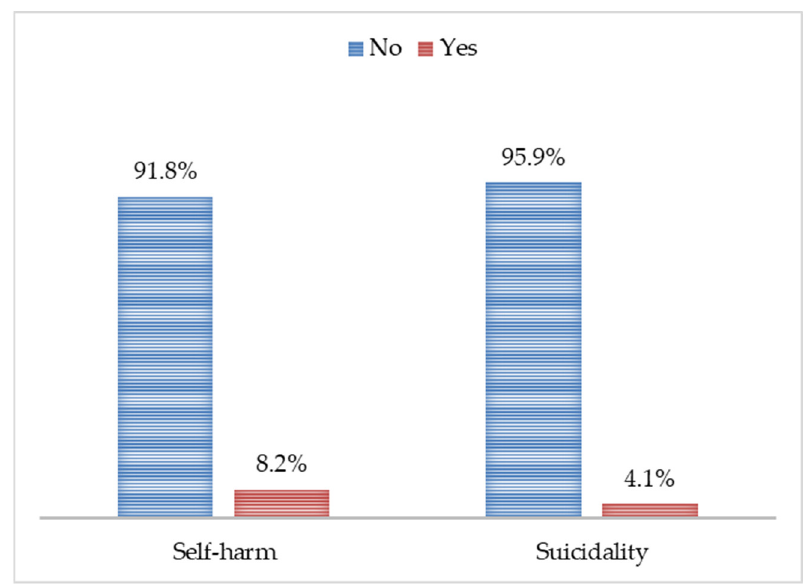
Figure 3. Proportion of self-harm and suicidality (yes vs. no). Table 3. Factors associated with self-harm (bivariate